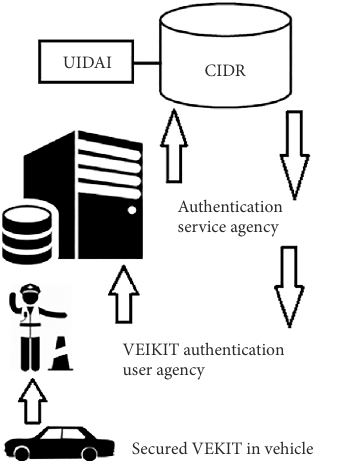
Figure 17. Proposed VEKIT